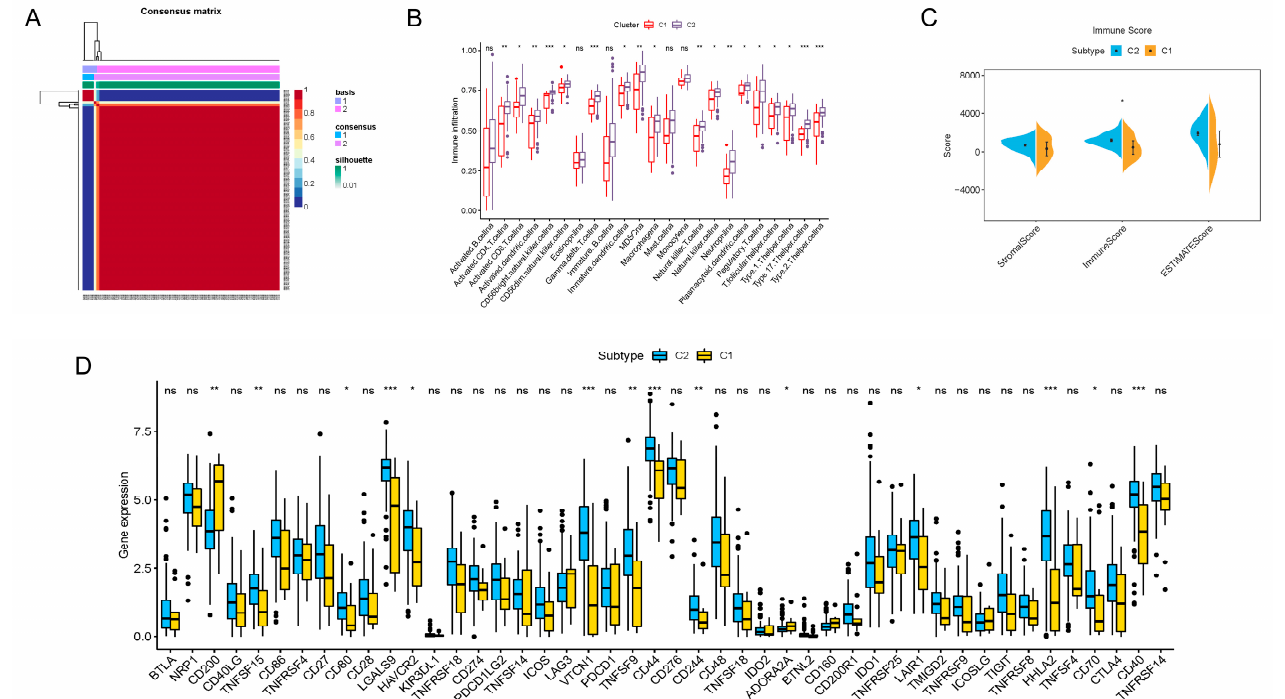
Figure 2. Consensus clustering of prognosis-related lncRNAs and construction of a risk score model in the PDAC cohort. ( A ) Consensus clustering matrix for k = 2. ( B ) Boxplots showing difference in immune cell infiltration between cluster 1 and cluster 2. ( C ) Results of the ESTIMATE algorithm, revealing that the main difference in the TIME between cluster 1 and cluster 2 was in the immune cell components. ( D ) Boxplots presenting results of difference analysis of multiple immune checkpoint blockade gene expression levels between cluster 1 and cluster 2. In the images, the scattered dots stands for values of gene expression and immune cell infiltration. In the boxes, the bottom borders and the top borders stand for the 25th and 75th percentiles respectively. The transversal line in the box stands for the median value. Statistical difference is expressed by asterisks, * p < 0.05, ** p < 0.01, *** p < 0.001, ns, not significant.